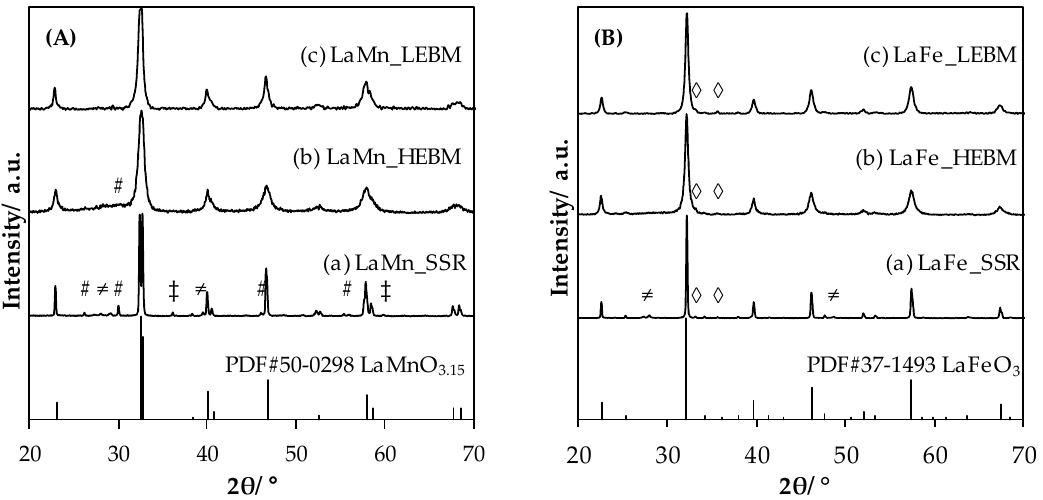
Figure 1. Diffractograms obtained for LaMnO 3.15 ( A ) and LaFeO 3 ( B ) after each synthesis step. SSR: solid state reaction, HEBM: high-energy ball milling, LEBM: low-energy ball milling. Bottom of the figure: vertical bars are for cited JCPDS reference. #, La 2 O 3 ; ‡ , Mn 3 O 4 ; (cid:44) , La(OH) 3 ; ♦ , Fe 2 O 3 .